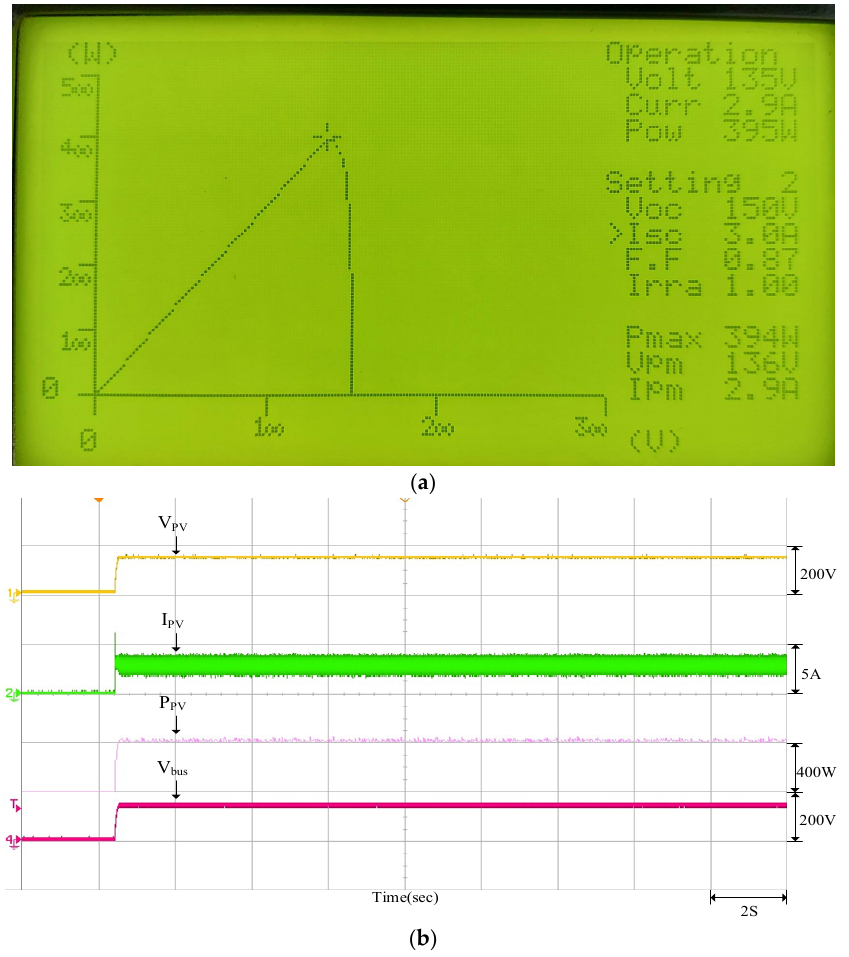
Figure 17. Under the maximum power tracking when the photovoltaic module outputs 400 W: ( a ) P–V characteristic curve diagram; ( b ) actual tested waveform.